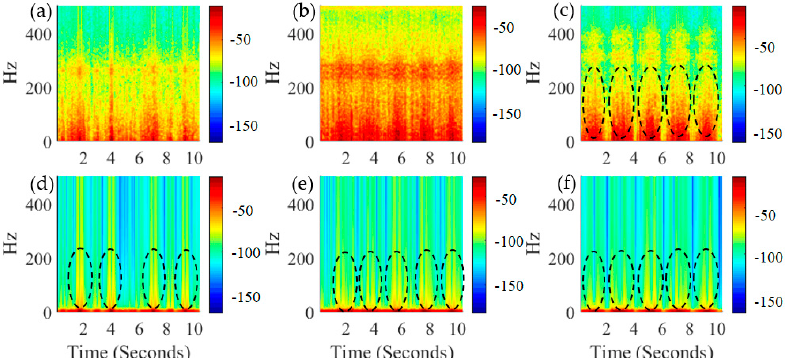
Figure 11. STFT analysis of the different processed signals. ( a ) STFT of HHT processed signal S1; ( b ) STFT of HHT processed signal S2; ( c ) STFT of HHT processed signal S3; ( d ) STFT of smoothing processed signal S1; ( e ) STFT of smoothing processed signal S2; ( f ) STFT of smoothing processed signal S3.